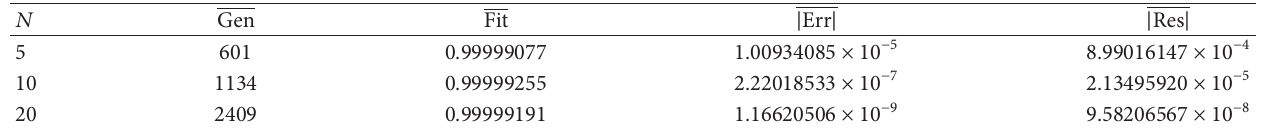
Table 12: The influence of the number of nodes on the convergence speed, the average fitness, and the corresponding errors of the algorithm for Bratu’s problems when 𝜇 = 1 .